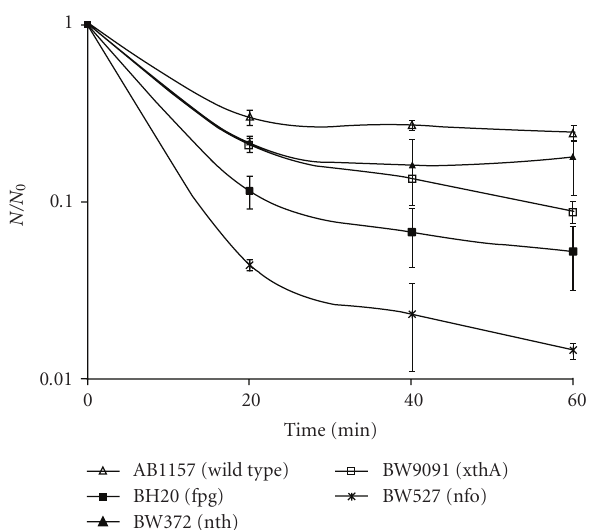
Figure 2: Survival fraction of E. coli AB1157, BH20, BW372, BW9091, and BW527 treated with UVA and SnCl 2 . Mid-log phase cells suspended in 0.9% NaCl were illuminated with 90 kJ/m 2 UVA, followed by SnCl 2 (25 μ g/mL), for di ff erent incubation times and the specific survival fractions. Survival fraction values are means ± standard deviations of the three isolated experiments.